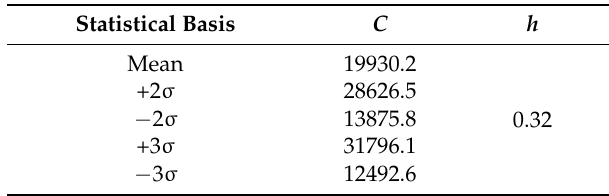
Table 1. Parameters for master S-N